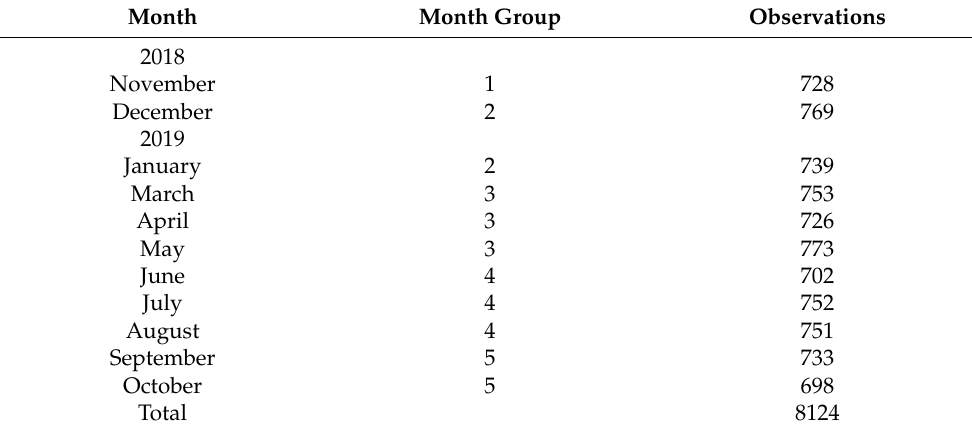
Table 4 are further extrapolated in Table 5 into the odds of a day exceeding the daily WHO limit. Any odds under 1 are represented by reduced odds and over 1 by increased odds of resulting in a high PM 2.5 concentration exceeding the WHO daily guidelines. Increased precipitation, increased windspeed, and Month group 5 (compared to Month group 1) have reduced odds of exceeding the WHO guidelines per day (Table 5). On Saturday, the odds of exceeding the WHO limit are sixfold compared to the reference day (Friday), and on Tuesday those odds decrease to threefold. Table 3. Logistic regression observation breakdown by month for 25 deployed sensors. Month Month Group Observations